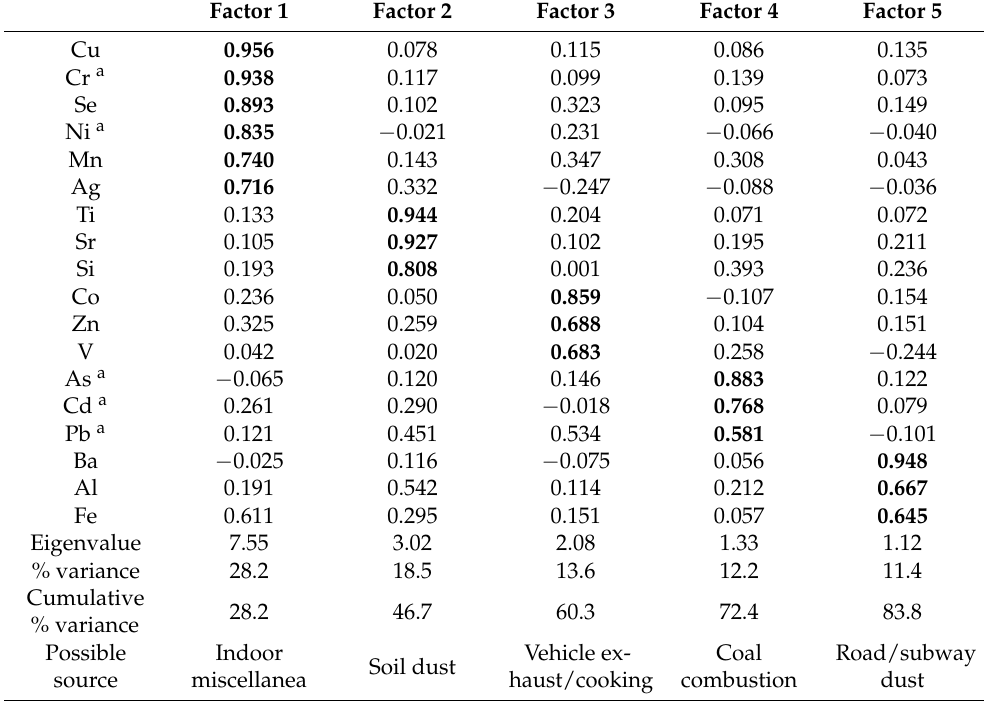
Table 2. Factor loadings from principal component analysis with varimax rotation. Boldface denotes high factor loadings considered as marker